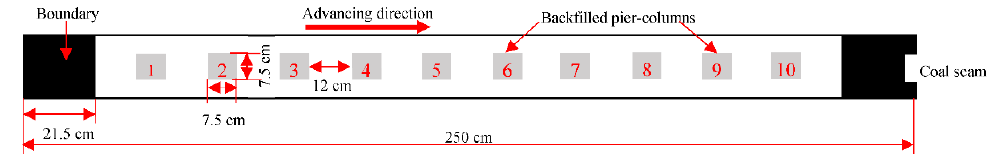
Figure 7. The positions of the pier-columns.